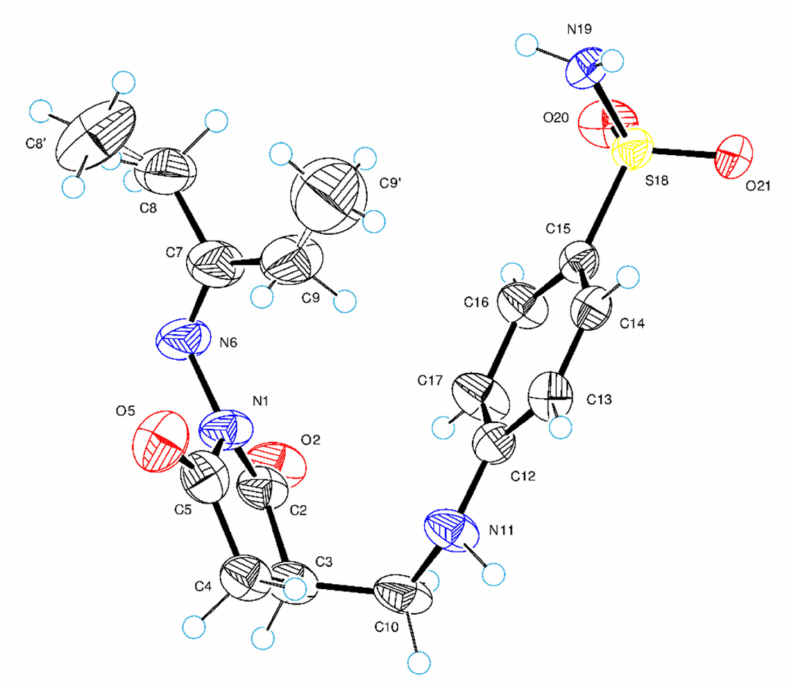
Figure 1. ORTEP (Oak Ridge Thermal-Ellipsoid Plot Program) molecular structure of compound 4a showing the atom-numbering scheme. The thermal displacement ellipsoids are drawn at the 50% probability level and hydrogen atoms are shown as small spheres of arbitrary